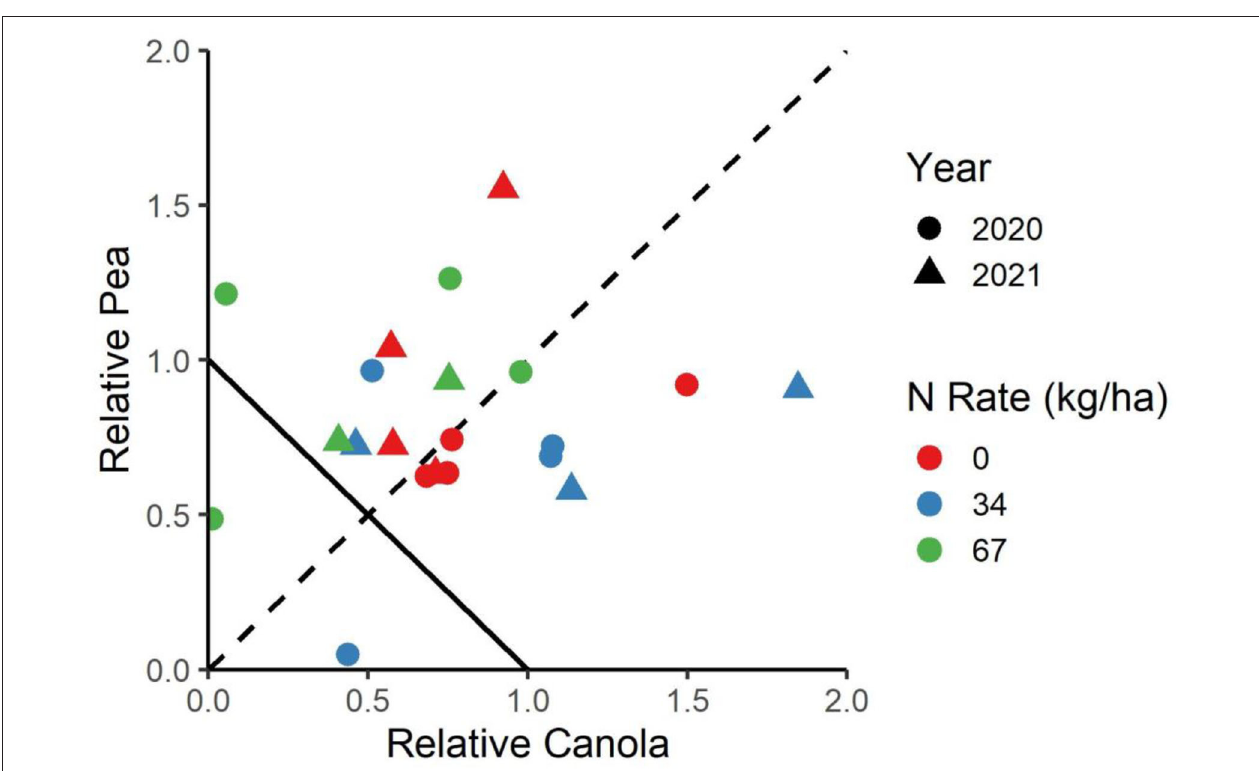
FIGURE 3 | The relative yield of canola and peas in the canola system. The negative-sloped line from (0.1) to (1.0) indicates the LER of the monocultures, while the dashed line indicates to which degree the peas or canola are favored.